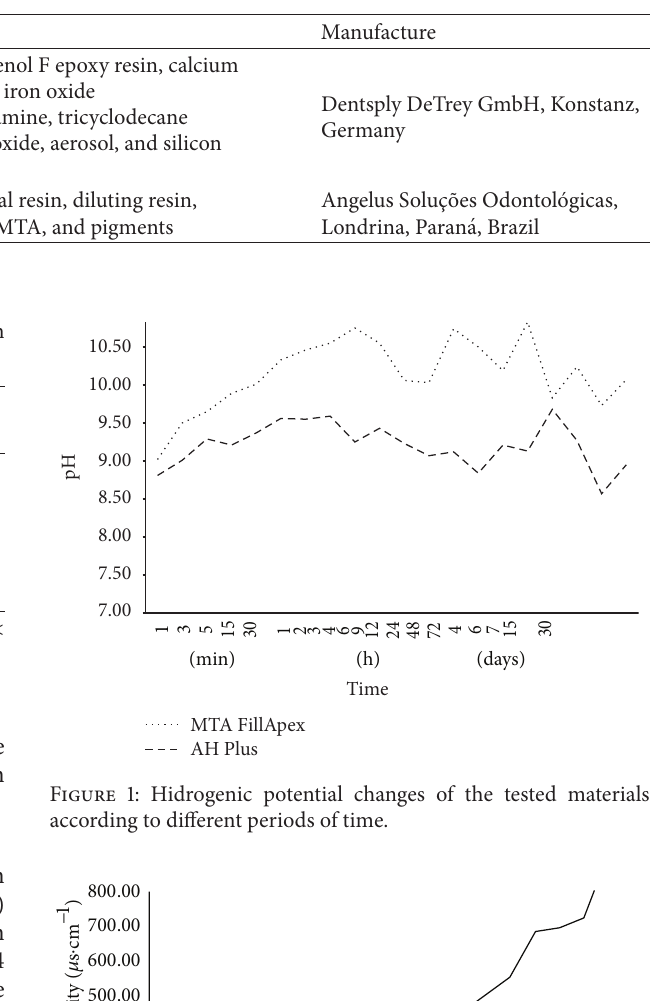
Table 1: Composition of the materials and their manufacturers.